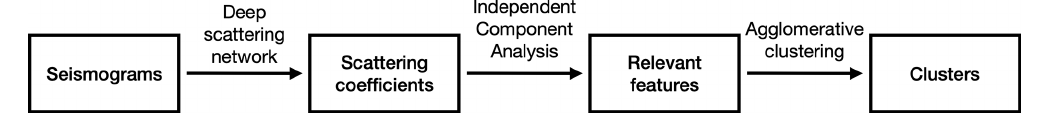
Figure A1. Computing scheme of the scatseisnet method. The seismograms are fed to a deep scattering network for extracting the scattering coefficients. The most relevant features are extracted from the scattering coefficients with an independent component analysis. Clusters are identified with an agglomerative-clustering